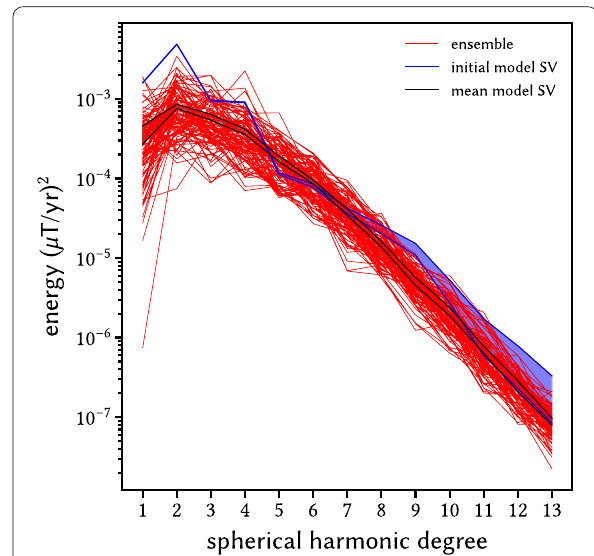
Fig. 4 Secular variation spectra at the Earth’s surface. Each thin red line corresponds to an ensemble member, prior to the ingestion of the initial model for 2019.0. The blue envelope is that defined by the initial model plus or minus one standard deviation. In black, the envelope defined by the mean of the ensemble plus or minus one standard